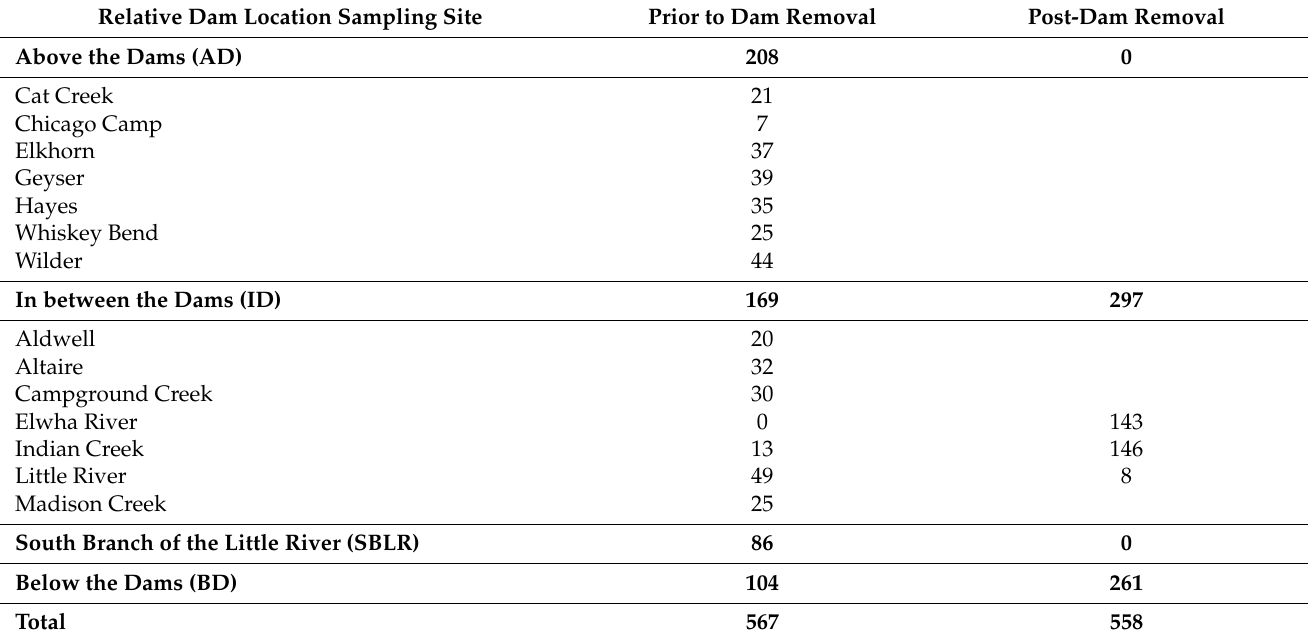
Table 1. All sequenced samples arranged by population (AD, ID, SBLR, and BD) and sampling site, ordered from upstream (top) to downstream (bottom) divided by relative anadromous barrier location.